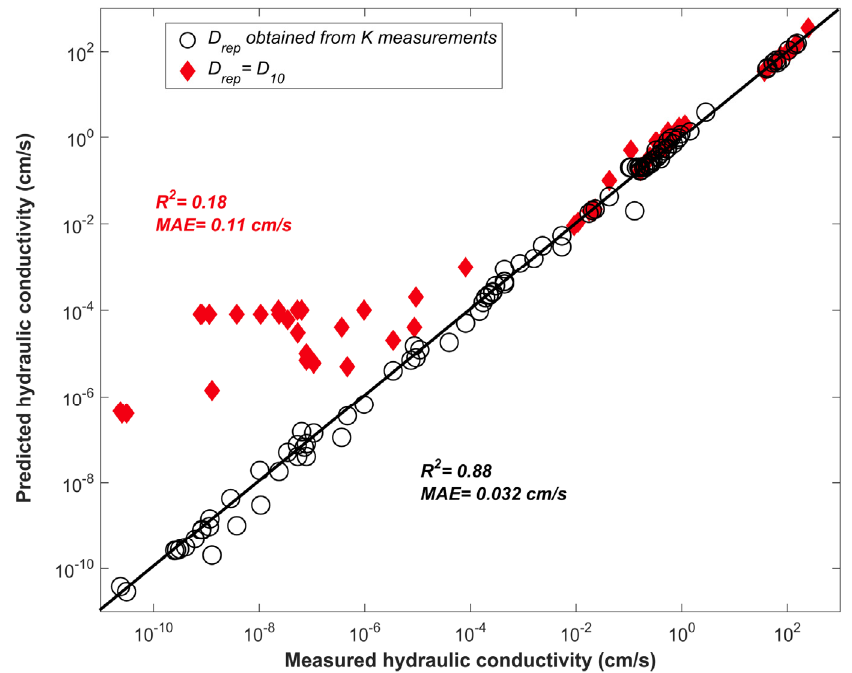
Figure 12. Comparison between the measured and predicted hydraulic conductivity using current model (Equations (13)–(18) and (19)–(21)). Red data points correspond to the predictions done by using D 10 and d 10 to define D repL and d repF in Equation (20) while the black circles refer to the prediction using K of endmembers as input parameters to estimate D repL and d repF . The use of D 10 and d 10 was not possible in some mixtures where the required particle size was not